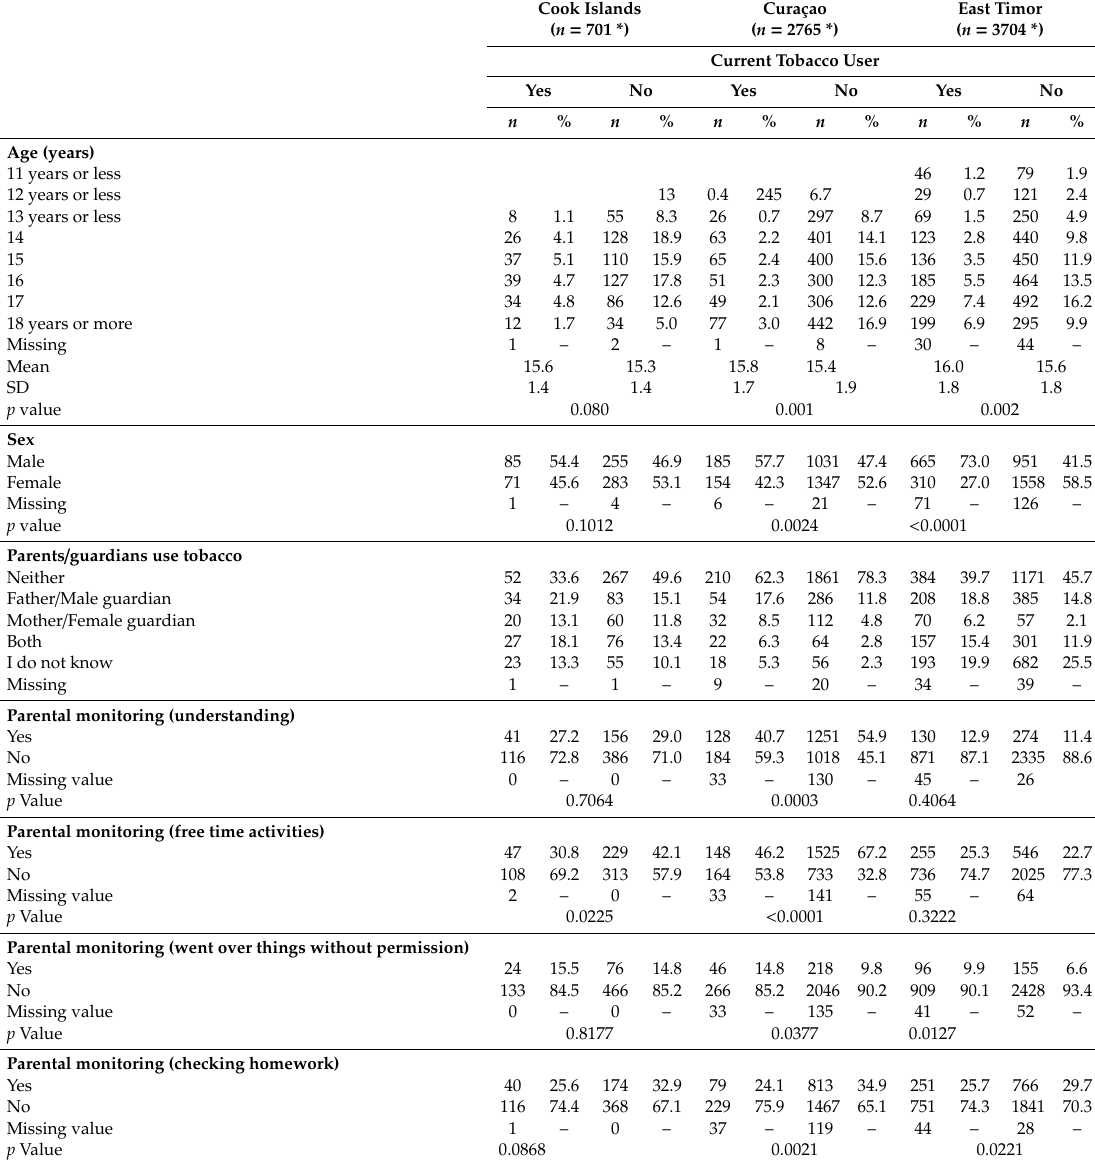
Table 2. Descriptive statistics and bivariate associations by current tobacco use (cigarette and / or other forms) status in school attending